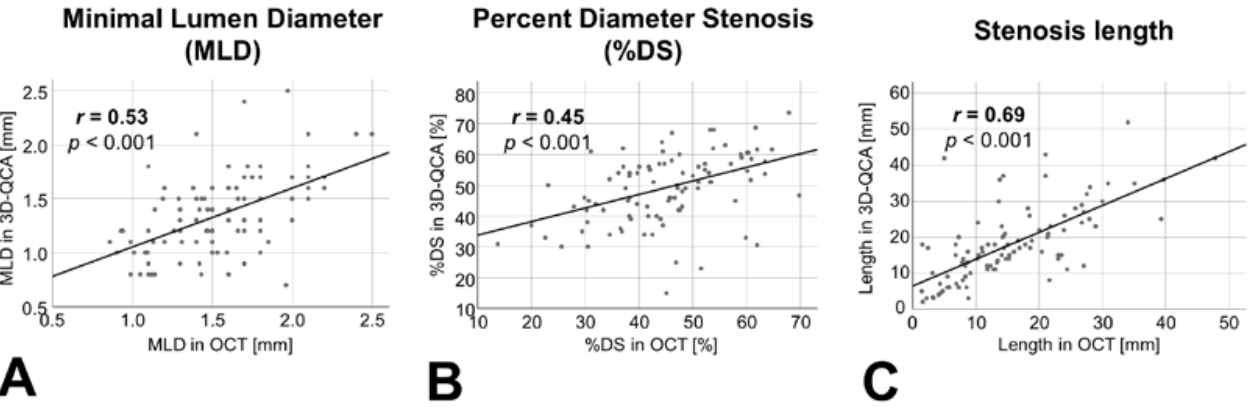
Figure 4. Association between OCT and 3D-quantitative coronary angiography (3D-QCA) in assessing stenosis geometry. A strong linear association between the two modalities to assess stenosis parameters could be demonstrated; exemplary, minimal lumen diameter (MLD, in ( A )), percent diameter stenosis (%DS, in ( B ) and stenosis length (in ( C )) are presented.